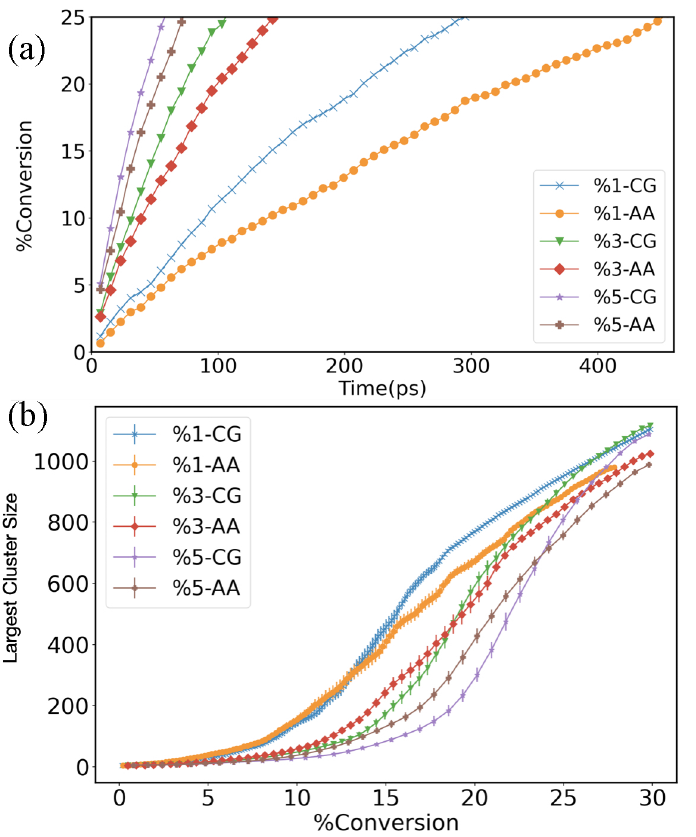
Figure 8. ( a ) Double bond conversion as a function of simulation time averaged by D-NEMD for the full-atomistic (AA) and the coarse-grained (CG) force fields at different initial radical concentrations. ( b ) Largest cluster size in function of double bond conversion. The curves were used to calculate the gel